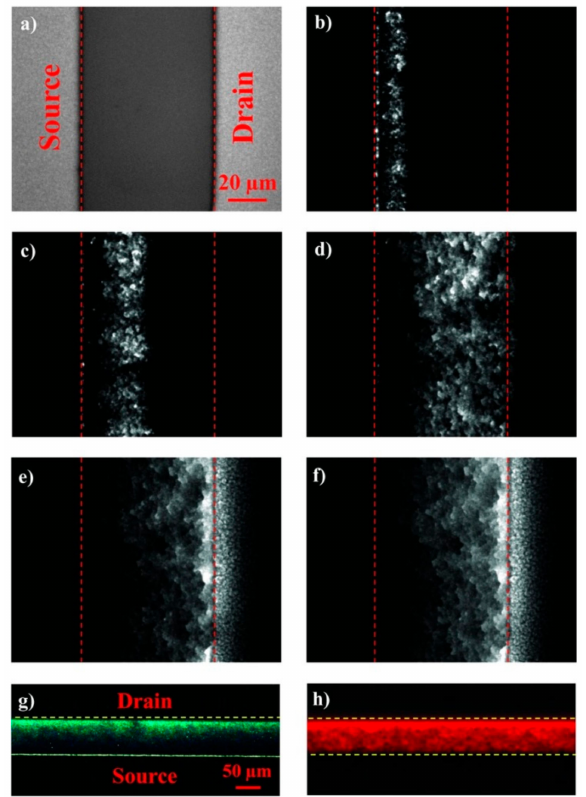
Figure 2. Images of the light-emitting area in the channel of an organic light-emitting transistor (OLET). A transmission optical microphotograph of the unbiased device is reported as the reference ( a ). The gate-source bias (V GS ) is varied at increasingly high voltages: − 20 V ( b ), − 40 V ( c ), − 60 ( d ), − 80 V ( e ) and − 100 V ( f ), while the drain-source bias (V DS ) is kept constant at − 100 V. Illuminated channels of green- ( g ) and red- ( h ) emitting OLETs are reported, with recombination layers based on di ff erent organic active materials. Reproduced with permission from [65] © 2020 by WILEY-VCH Verlag GmbH & Co. KGaA,